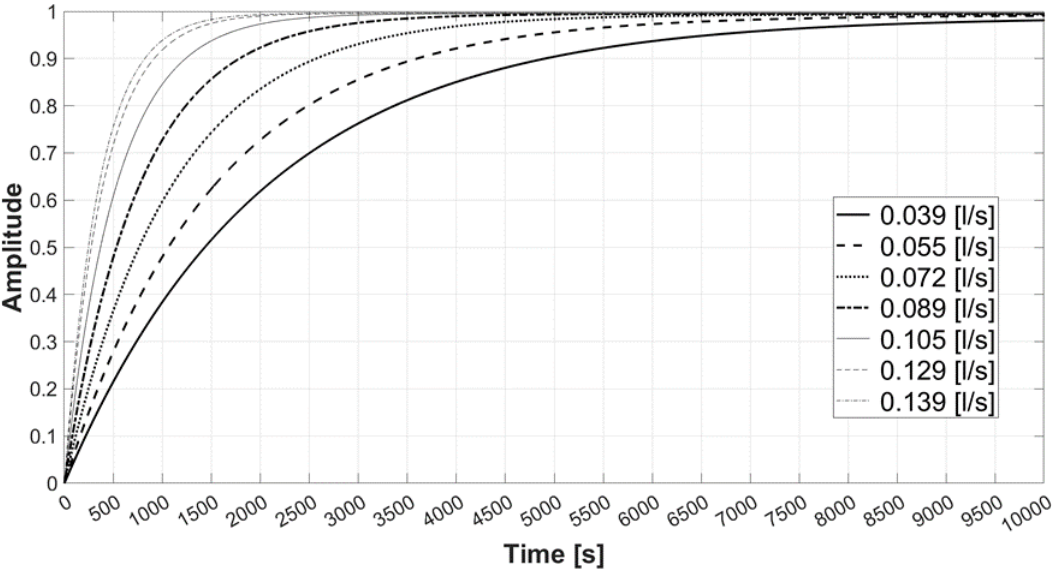
Figure 17. Curve of the medium outlet temperature at a pump output between 0.039 [l/s] and 0.139 [l/s].